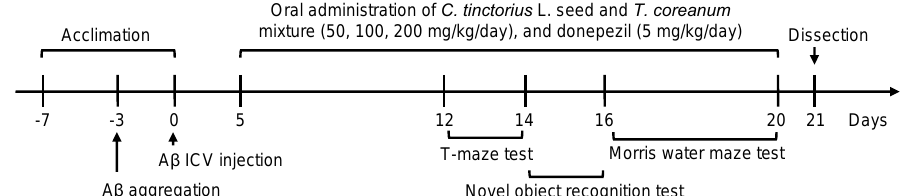
Figure 1. Experimental design.